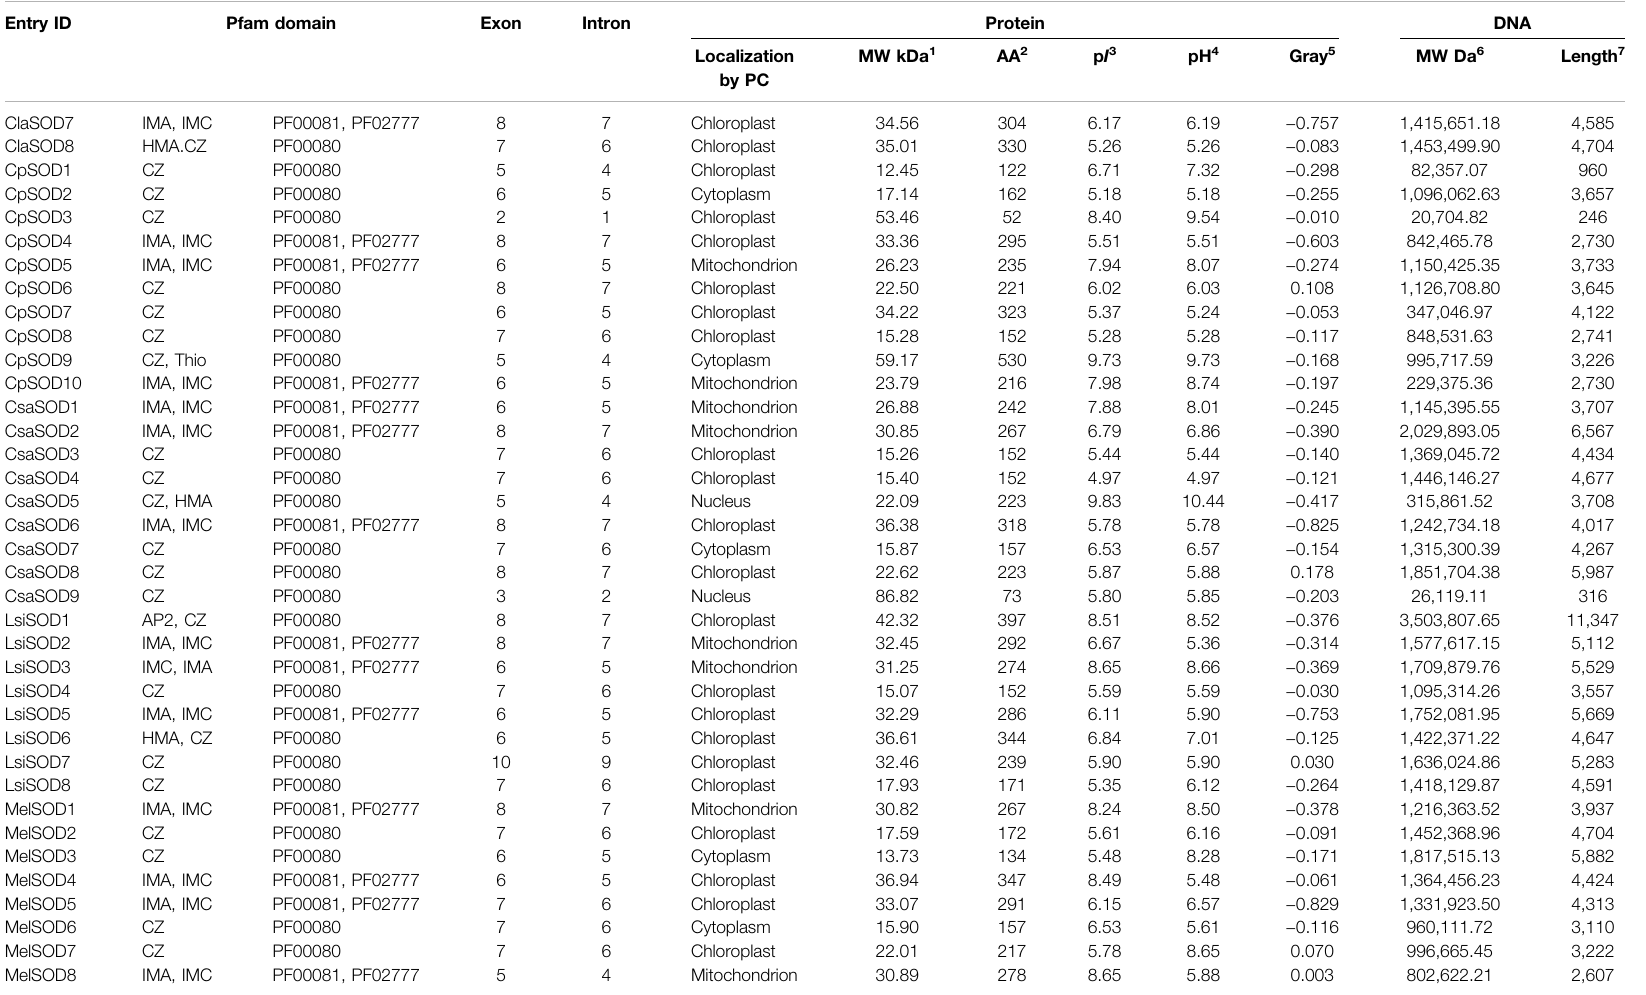
TABLE 1 | Physio-chemical characteristics of 43 SOD identi fi ed genes and sequence information in fi ve species of Cucurbitaceae family. Entry